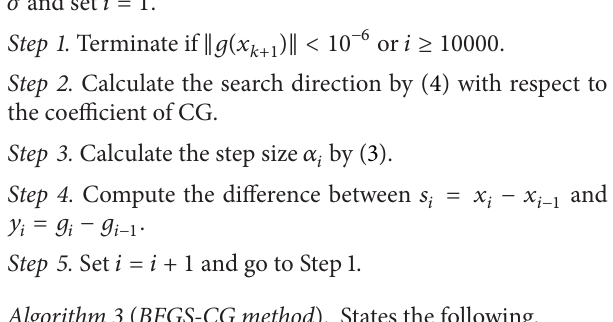
Algorithm 3 ( BFGS-CG method ). States the